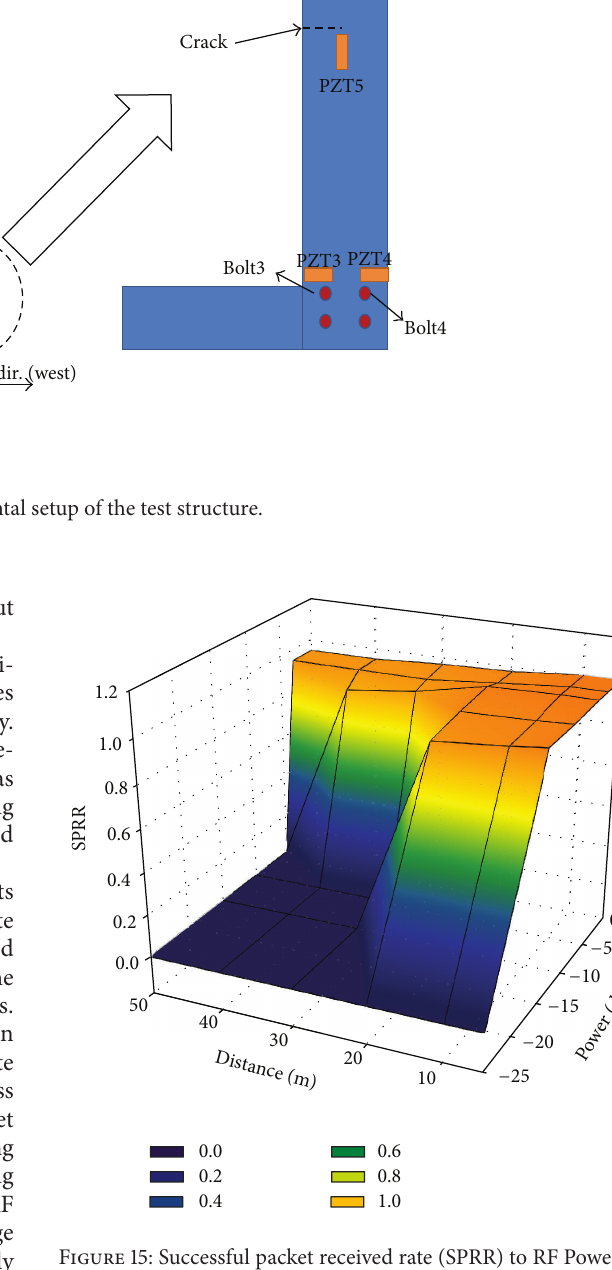
Figure 15: Successful packet received rate (SPRR) to RF Power and